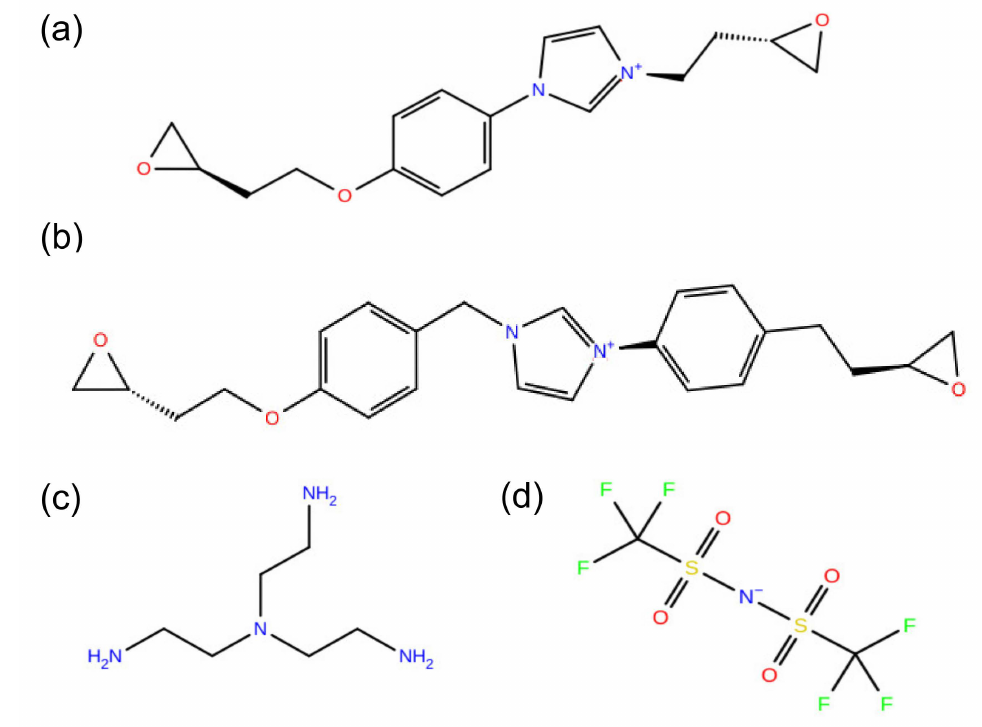
Figure 1. Molecular structures of cationic ( a ) EIM2 and ( b ) EIM1 monomers, ( c ) tris(2- aminoethyl)amine (TAEA) curing agent, and ( d ) bis(trifluoromethanesulfonyl)imide (TFSI − )